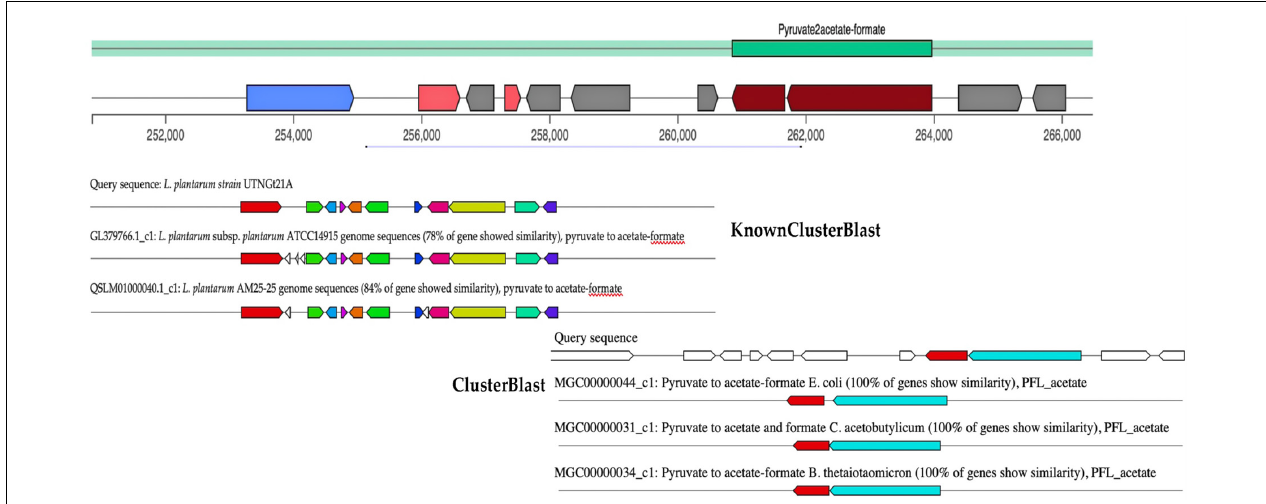
FIGURE 4 | gutSMASH run for query sequence (UTNGt21A) predicting one MGC region, type pyruvate to acetate-formate. The KnownClusterBlast results showed the gene similarity from this branch with other genes of Lactobacillus species from database. The ClusterBlast output shows that this gene cluster does not have homologous MGCs among another Lactobacillus present in the database. Genes marked with the same color are interrelated. White genes have no